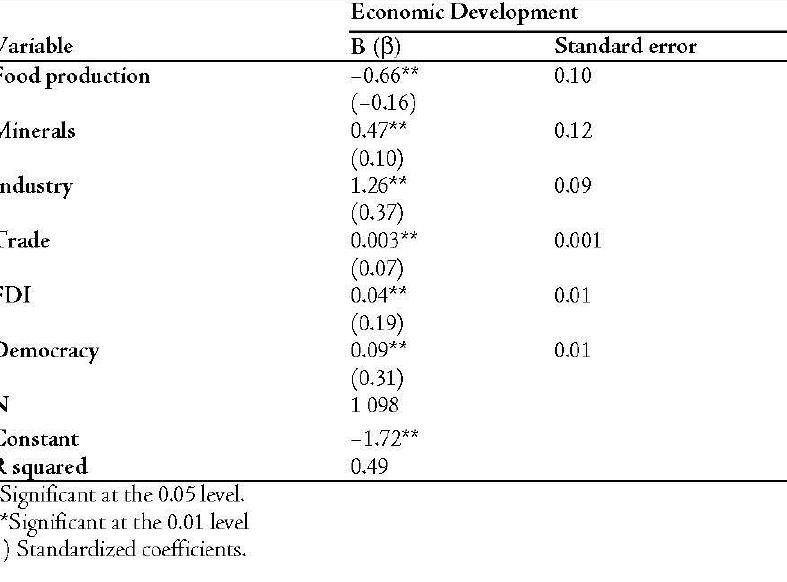
OLS Regression for Inequality, 1980-92 OLS Regression for Economic Development,